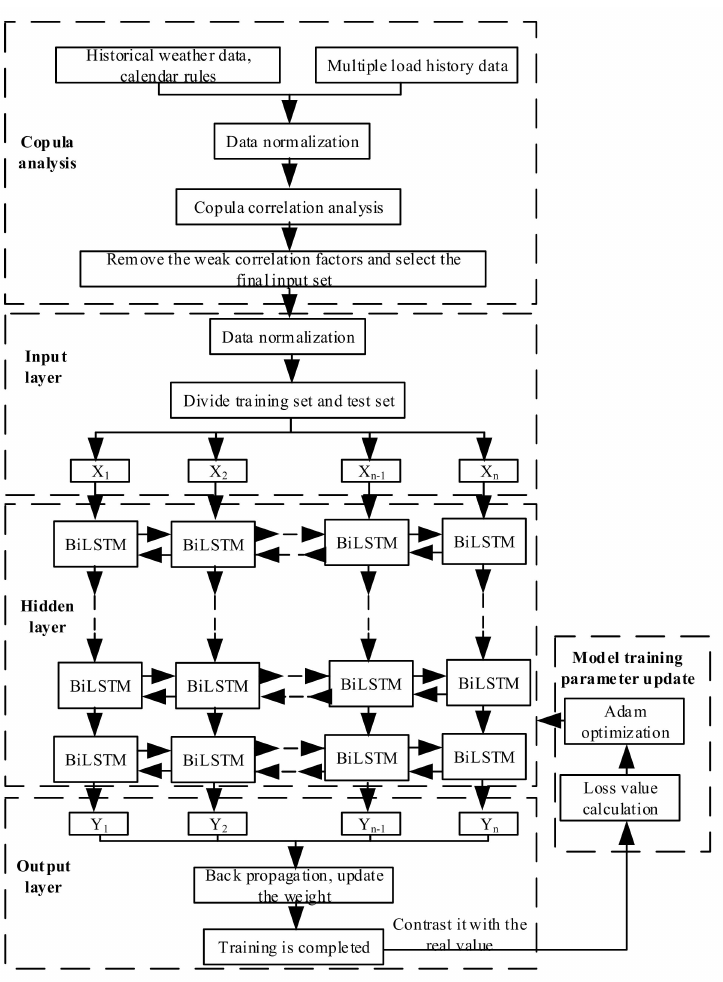
Figure 3. Based on the overall framework of Copula-DBiLSTM neural network